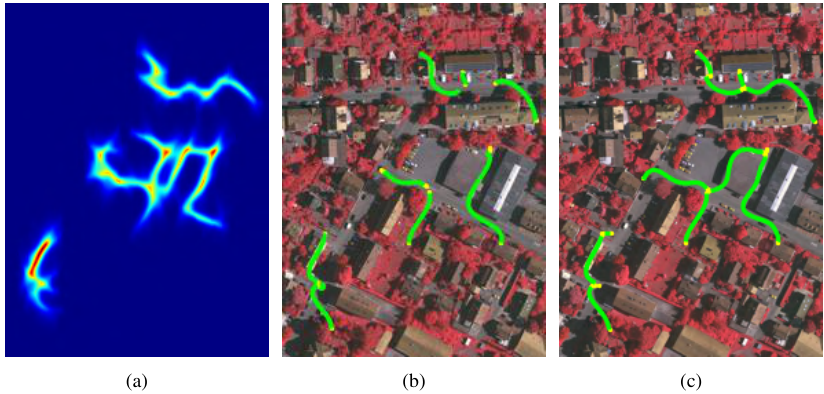
Figure 8. Results obtained by the traditional approach using the chosen algorithm which uses a traditional computer vision and probability based method. (a) The probability matrix showing the pixels which are likely to be a part of the road network and (b) The first step of the road detection process extracts the network segments with the highest probabilities. (c) The final road detection result after running the active shape growing method of the old algorithm (The active shape iteratively follows the highest next probability pixel, starting from the end points of the road segments extracted in the previous